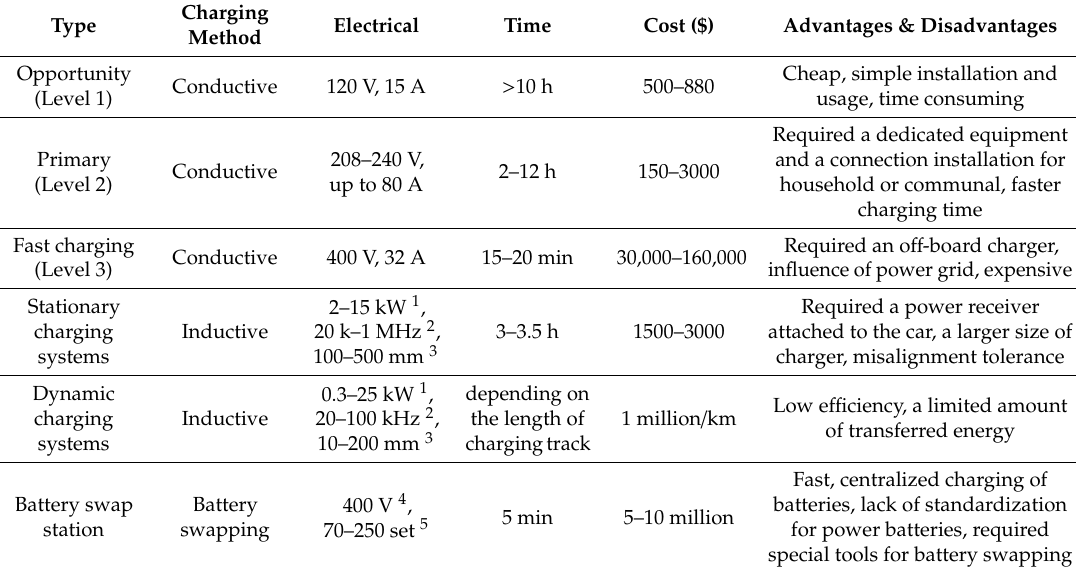
Table 3. Characters of di ff erent charging